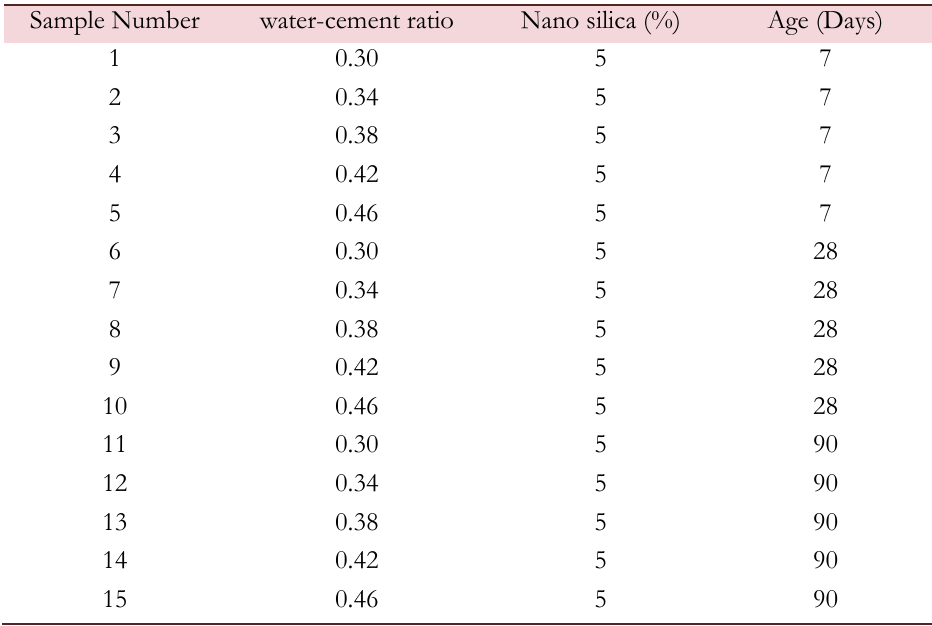
Table 1: The properties of the studied samples in the present